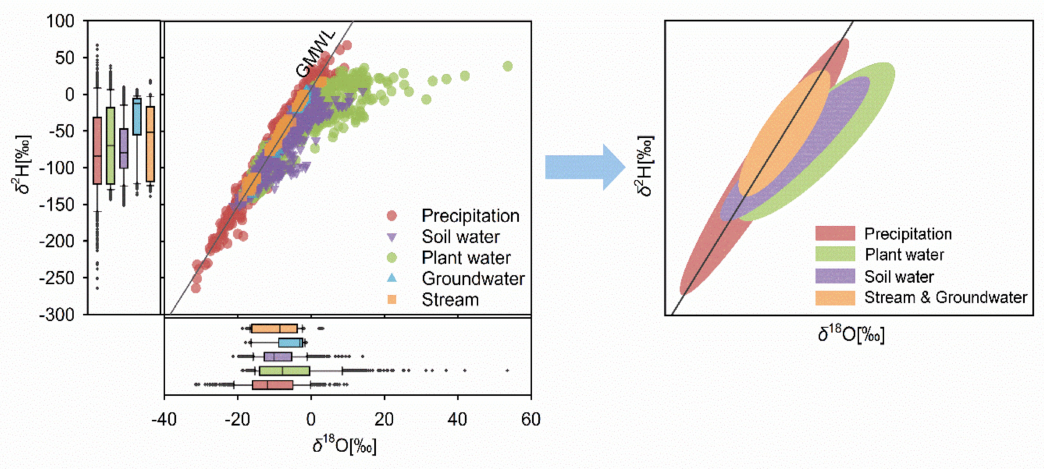
Figure 1. Evaluation of ecohydrological-separation (ES) hypothesis based on dual-isotope plot method, i.e., isotopic di ff erences in plant water, soil water, groundwater and stream. Data from [8,11,14,27,30,48–53].